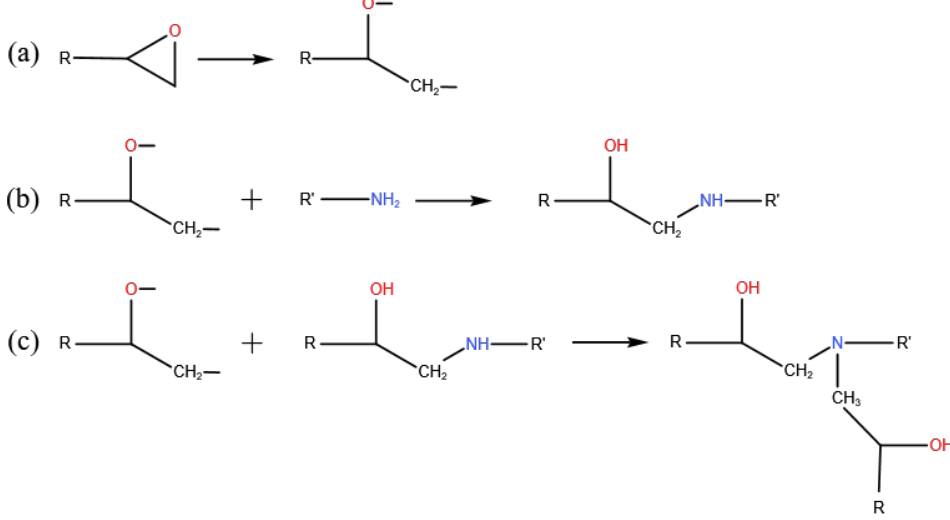
Figure 2. Cross-linking process of DGEBA/JEFFAMINE ® -D230 system: ( a ) The opening of the epoxide ring. ( b )The creation of bonds between the epoxy and the primary amine. ( c ) The creation of bonds between the epoxy and the secondary